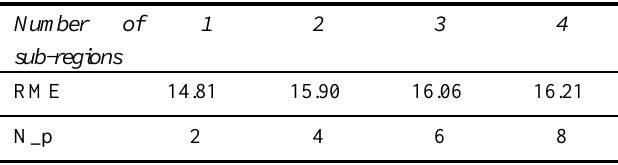
Table 1. The reconstructed results with different sub-regions.